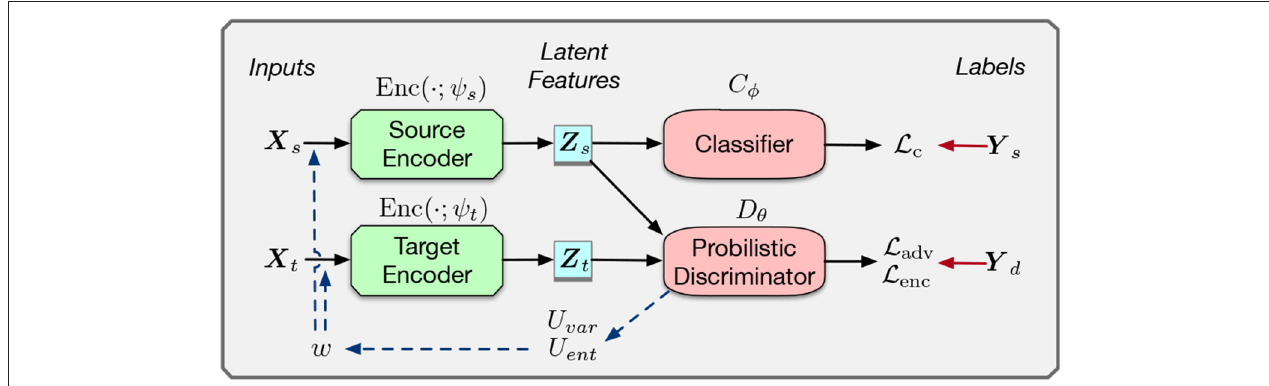
FIGURE 2 | Framework for adversarial domain matching with uncertainty reweighting. Y s and Y d are the source and domain labels, respectively. Model blocks are represented as rectangles and losses as ellipses. The concrete part is a general framework of of adversarial domain matching. The dash lines represents the process of our uncertainty